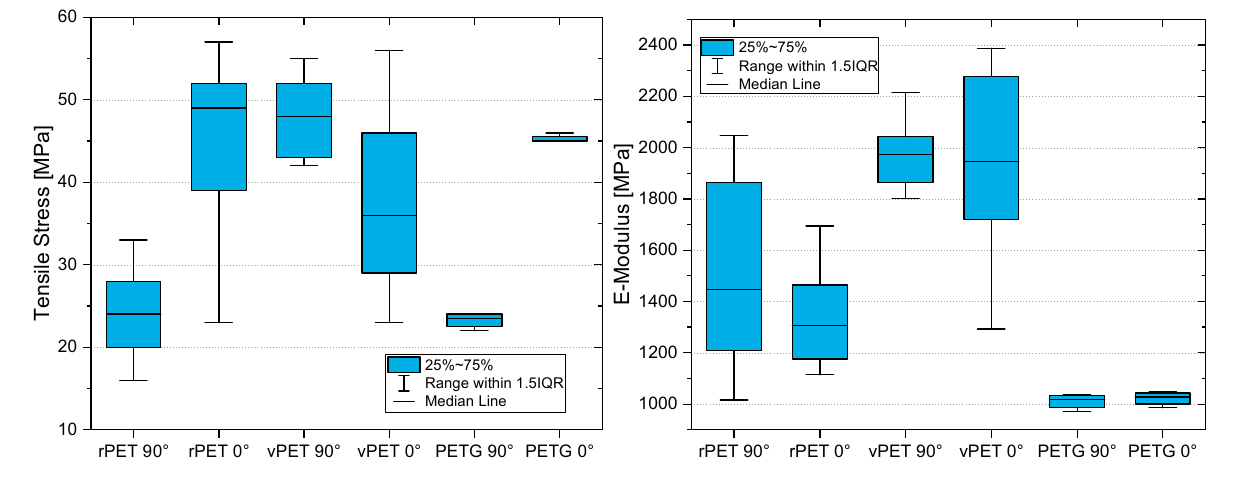
Figure 17. Statistical dispersion of the tensile stress results ( left ) and of the E-modulus ( right ).